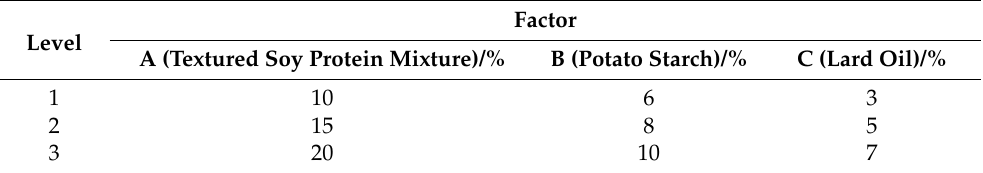
Table 2. Orthogonal test factor level table.